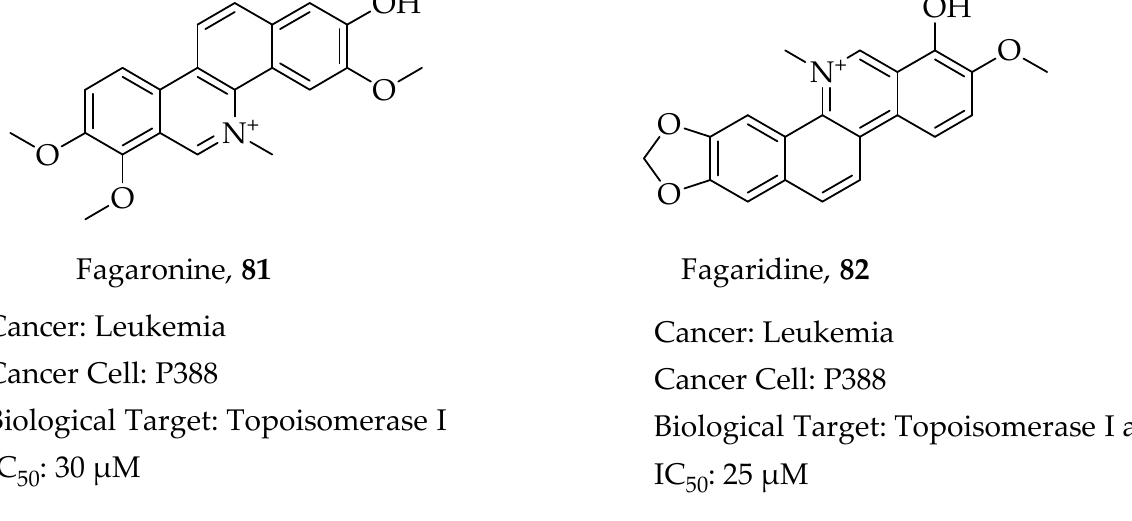
Figure 15. Chemical structures of Fagaronine and Fagaridine with a summary of their biological activity towards selected cancer targets.